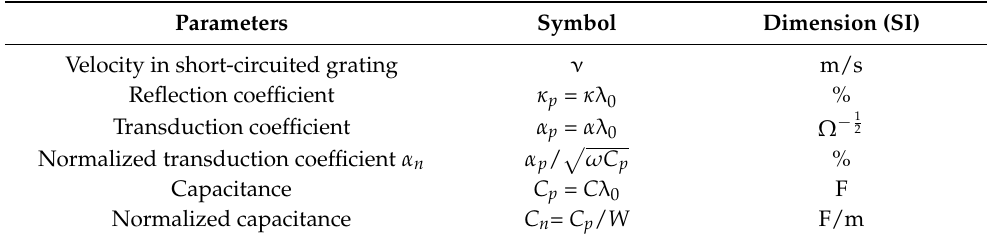
Table 1. Normalized COM